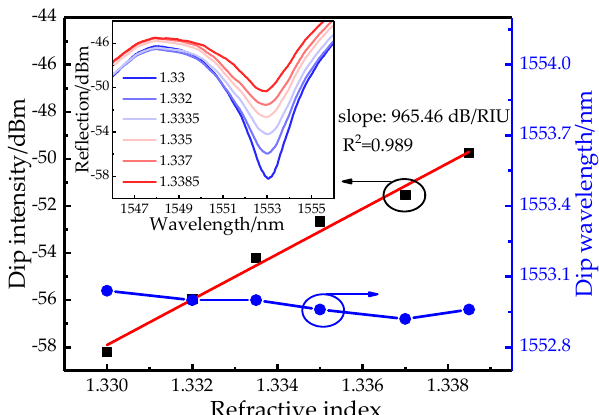
Sensors 2019 , 19 , x FOR PEER REVIEW Figure 9. Wavelength and intensity relationships in a double-pass (DP) structure with varied SRI.